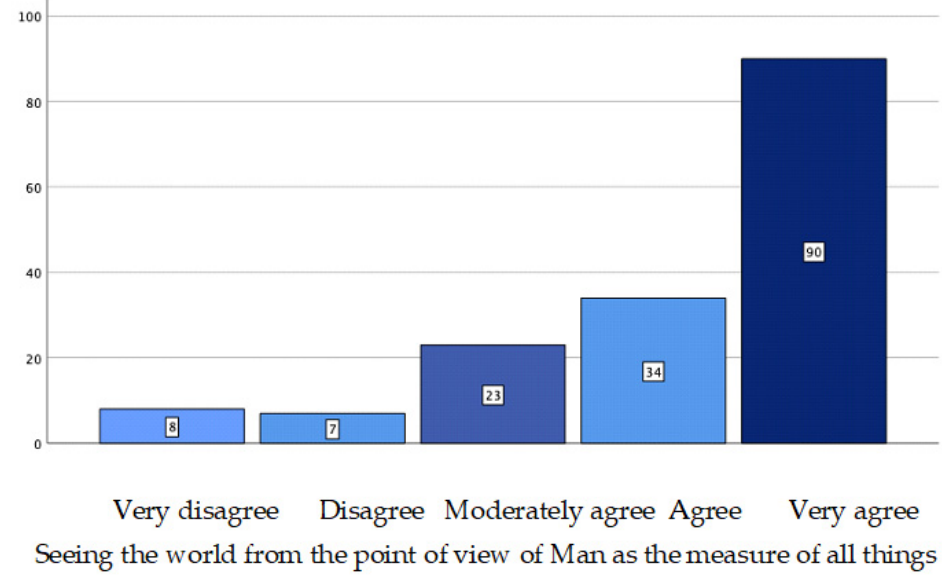
Figure 3. Contingency graph. Item q. 3.3.